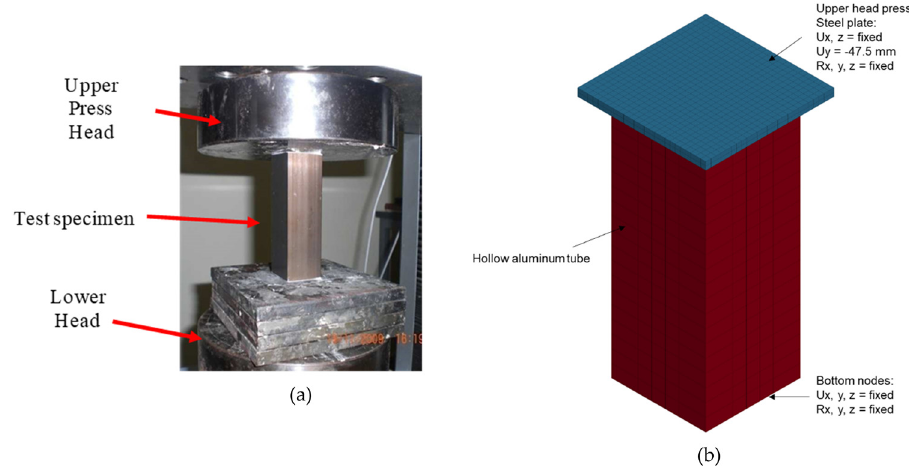
Figure 1: ( a ) Experiment scheme of the hollow tube under axial loading [ 15 ] . ( b ) Discretized specimen in fi nite element